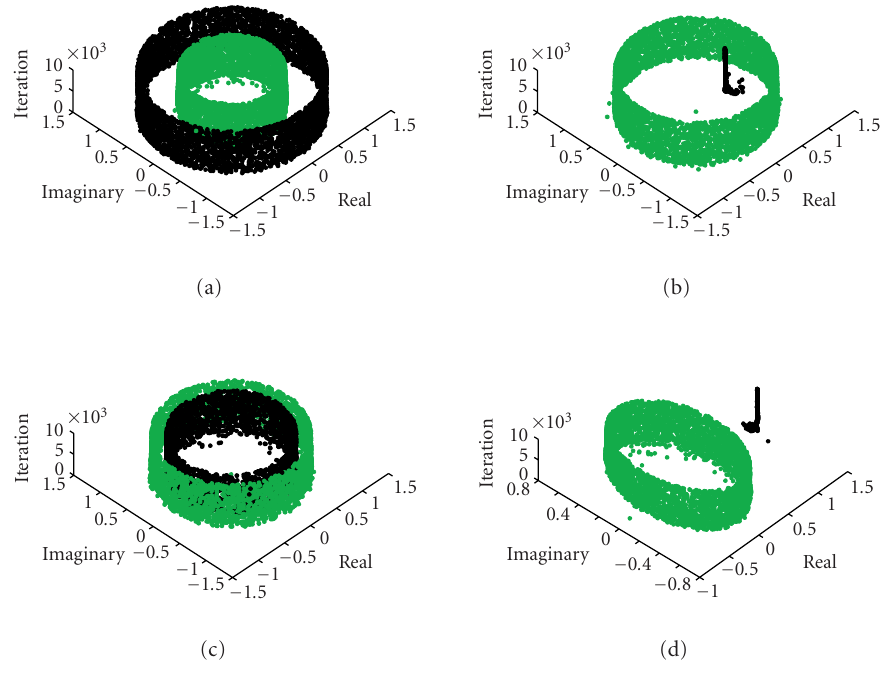
Figure 2.3. Dynamics for random cycles. Shown are the iterates v n given by (2.1) with (a) a n